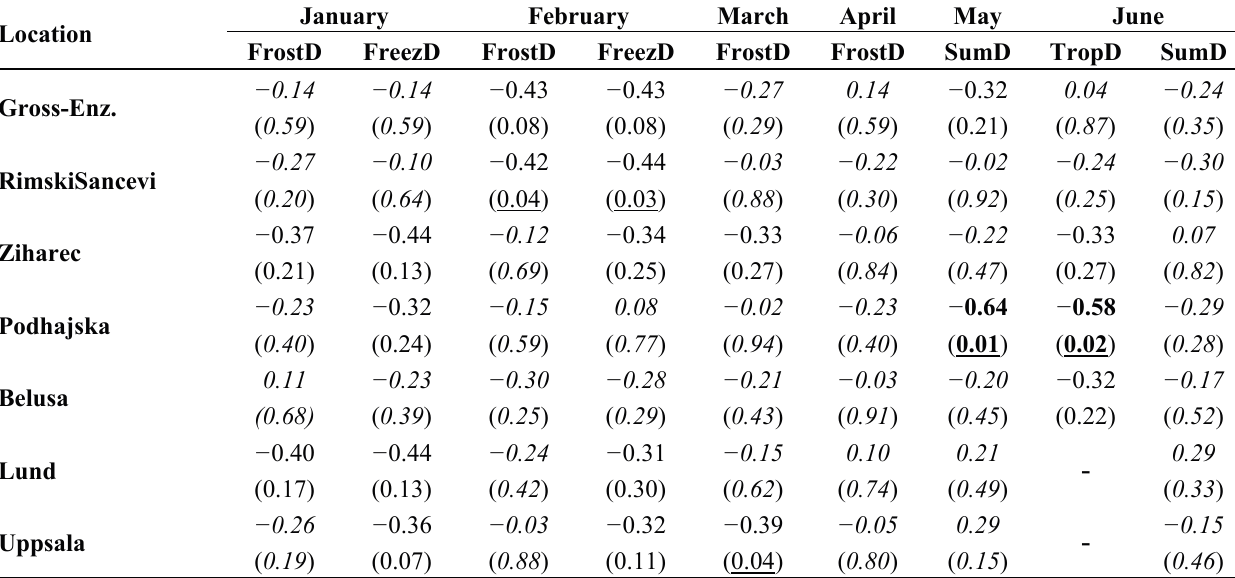
Table 7. Correlation coefficients and p values (in brackets, underlined values are significant) between AMI describing number of days with extreme temperatures and observed WW yield. No effect: 41 of 63 ; with effect: 2 of 63 . Location Gross-Enz.